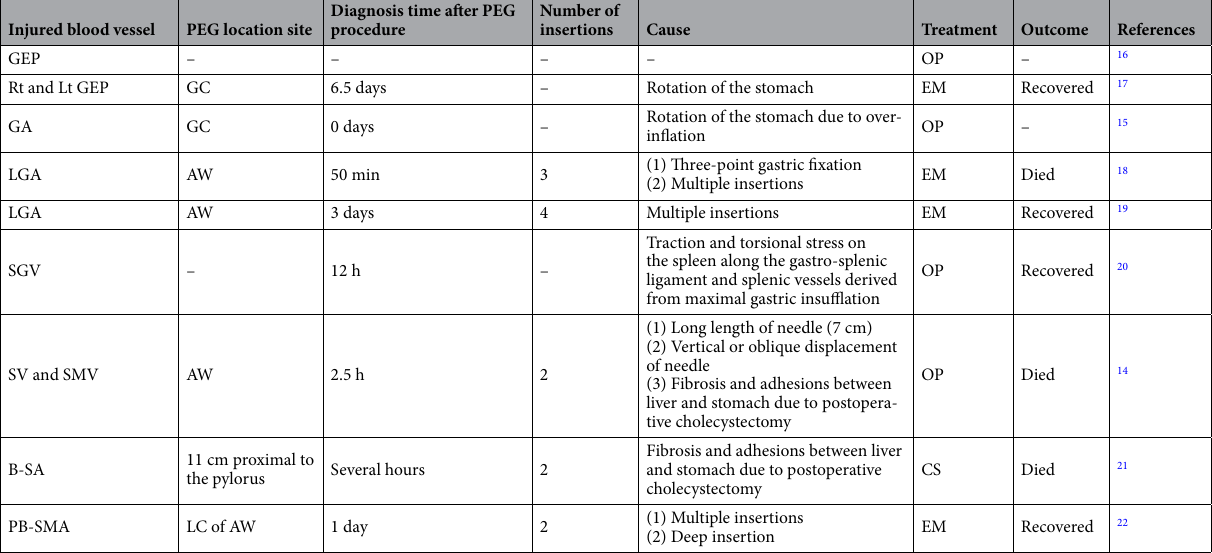
Table 4. Reported cases of vessel injury associated with PEG insertion. AW anterior wall, B-SA branch of splenic artery, CS conservative treatment, EM embolization, GA gastric artery, GC greater curvature,